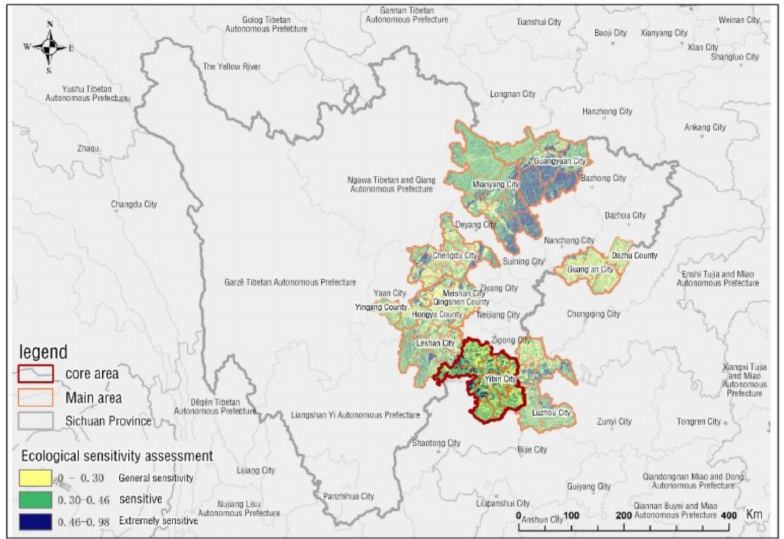
Figure 16. Analysis of ecological sensitivity of research areas in Sichuan